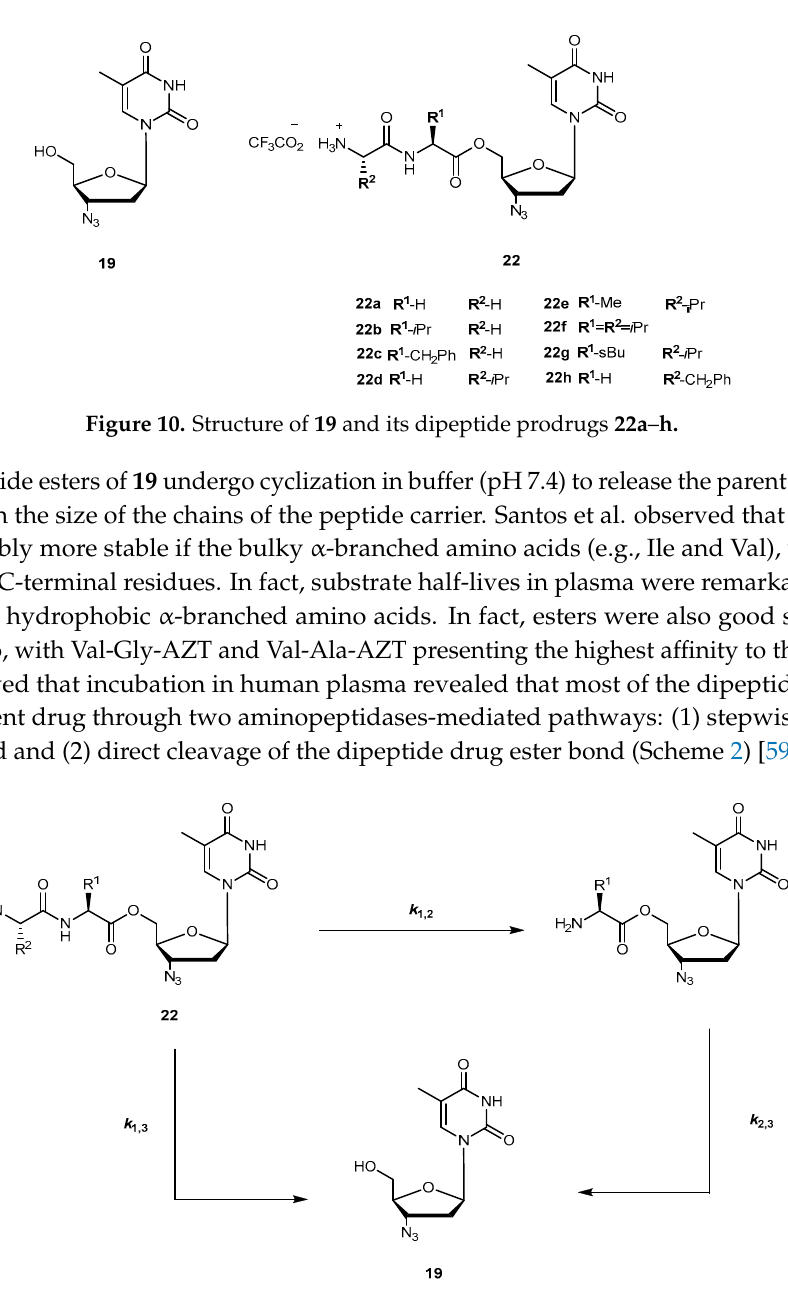
Scheme 2. Pathways observed for releasing of 19 by dipeptide esters 22 in human plasma (reproduced from